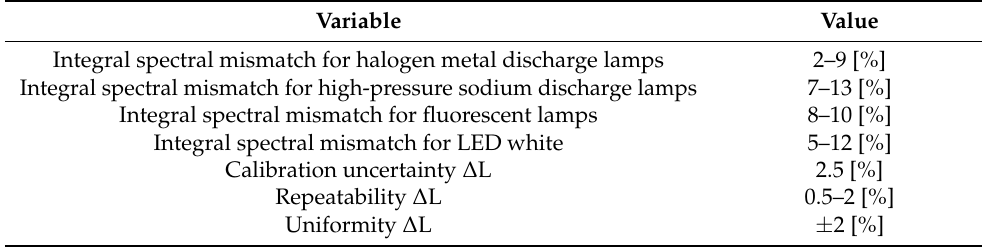
Table 1. Lighting characteristics of the reference camera photometer.